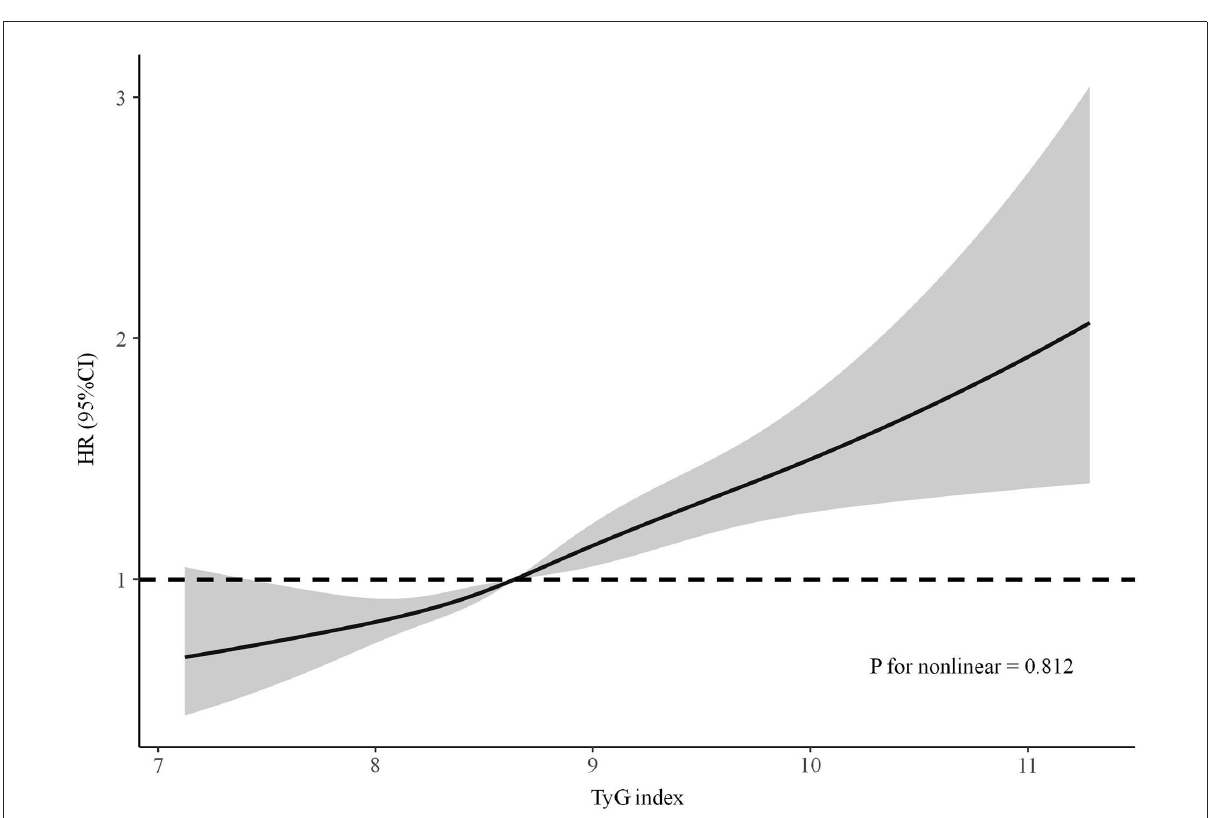
FIGURE1 The adjusted restricted cubic spline of the association between the triglyceride–glucose index and incident chronic kidney disease. Adjusted for age, sex, diabetes mellitus, systolic blood pressure, diastolic blood pressure, BMI, waist circumference, baseline eGFR, total cholesterol, exercising daily, drinking daily, and currently